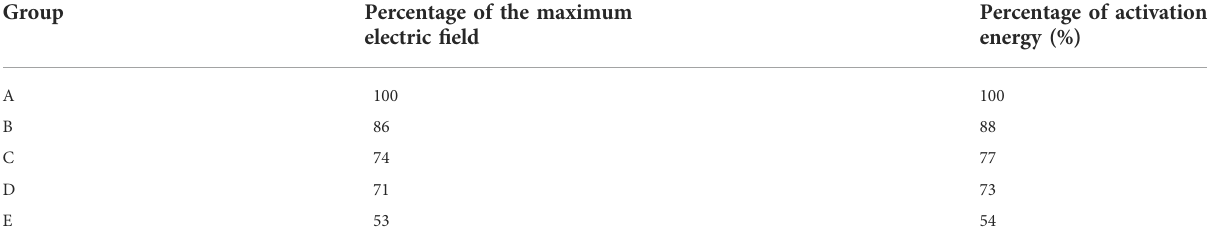
TABLE 2 Maximum electric fi eld and activation energy ratio of other groups to group A. Group